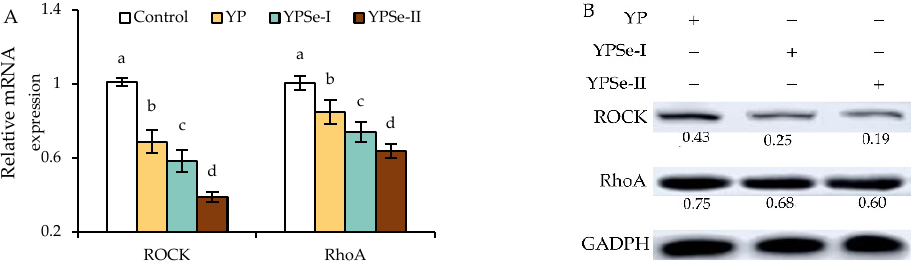
Figure 8. Relative mRNA content ( A ) and protein expression ( B ) of ROCK and RhoA in IEC-6 cells incubated with YP, YPSe-I, and YPSe-II for 24 h. Different lowercase letters above the columns denote a significant difference in the one-way ANOVA means ( p < 0.05).